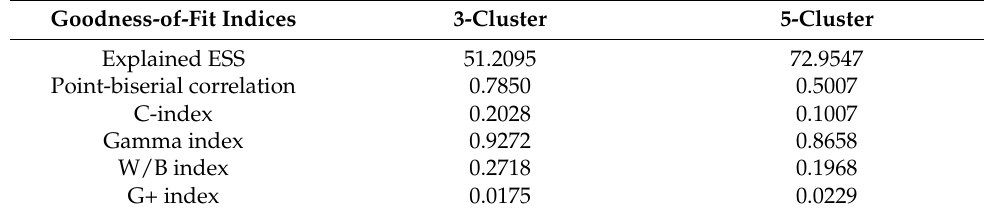
Figure 1. Error sum of squares plot for the activity cluster solution. ESS = error sum of squares. Table 2. Fit indices of the three- and five-cluster solution identified through K-means cluster analysis.